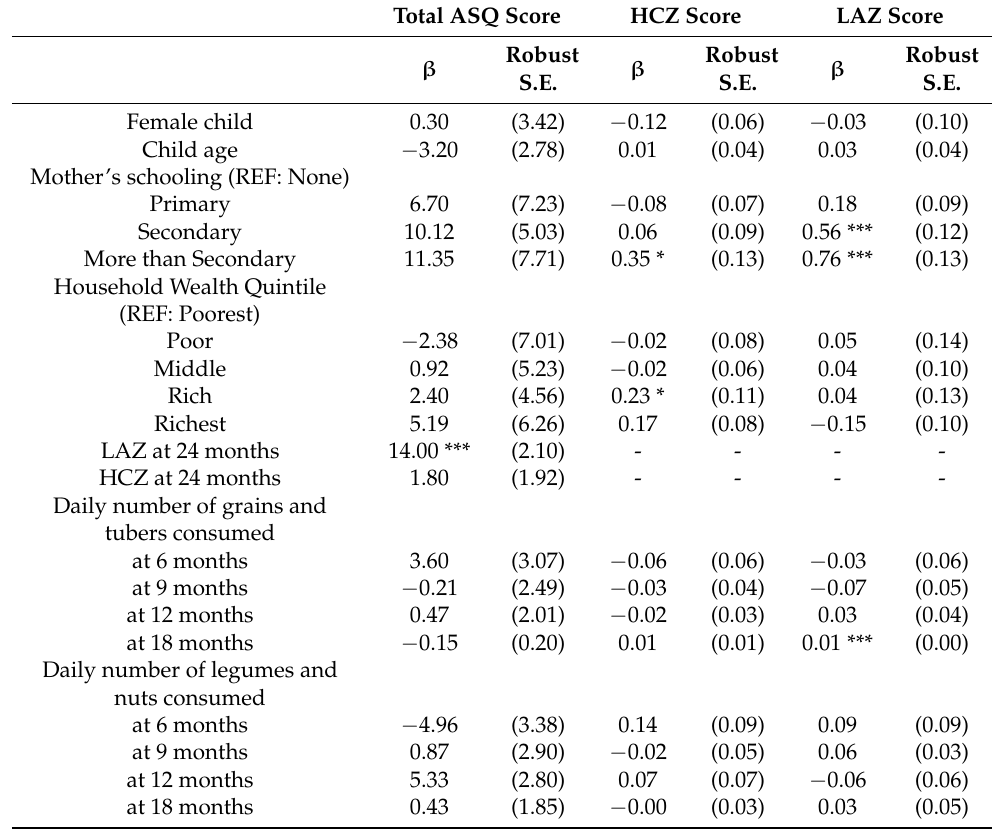
Table A2. AssociationbetweenASQscore,